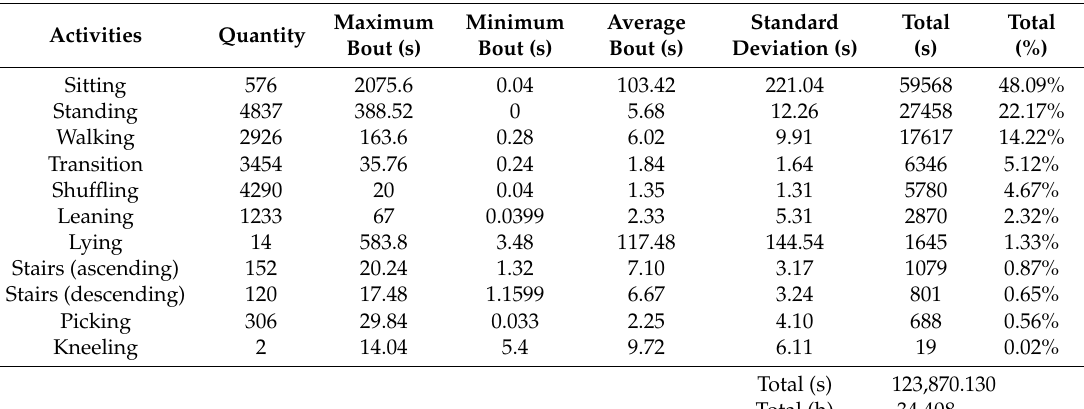
Table 10. A summary of the out-of-lab activities, excluding Undefined, Static, Dynamic, Shake and Jumping, which were used for synchronisation.